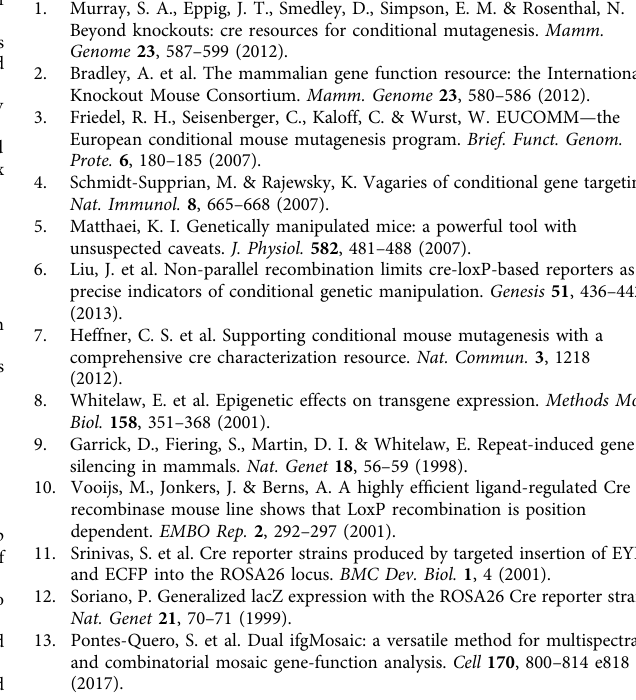
genes sequences. For RNA isolation, a minimum of 15,000 cells were sorted directly to RNeasy Mini Kit RLT buffer (Qiagen). RNA was extracted according to the Qiagen protocol. cDNA was synthetized with the High Capacity cDNA kit from Applied Biosystems (AB). cDNA was pre-ampli fi ed with the Taqman PreAmp Master